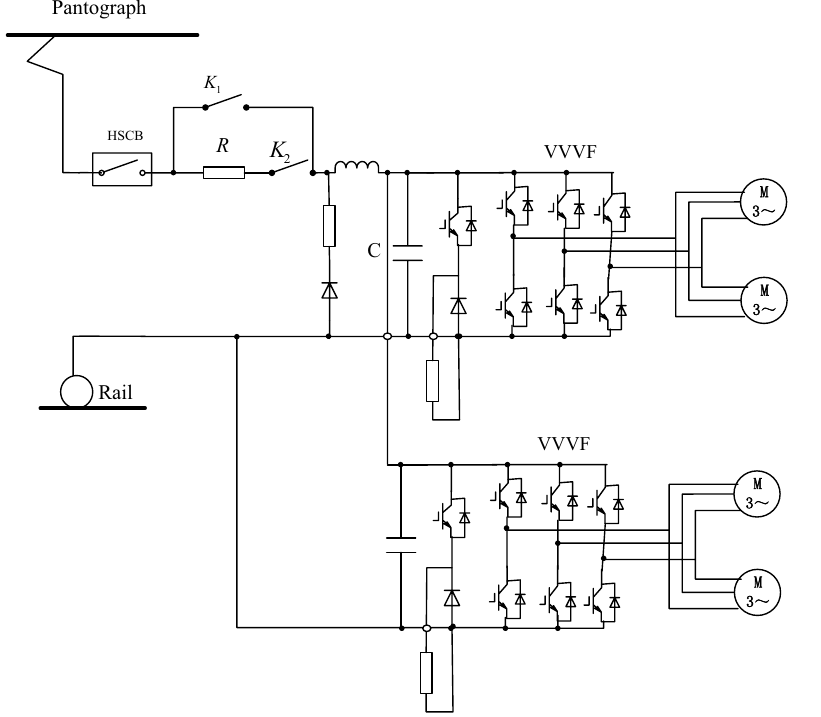
Figure 1. Schematic diagram of electrification for metro traction drive